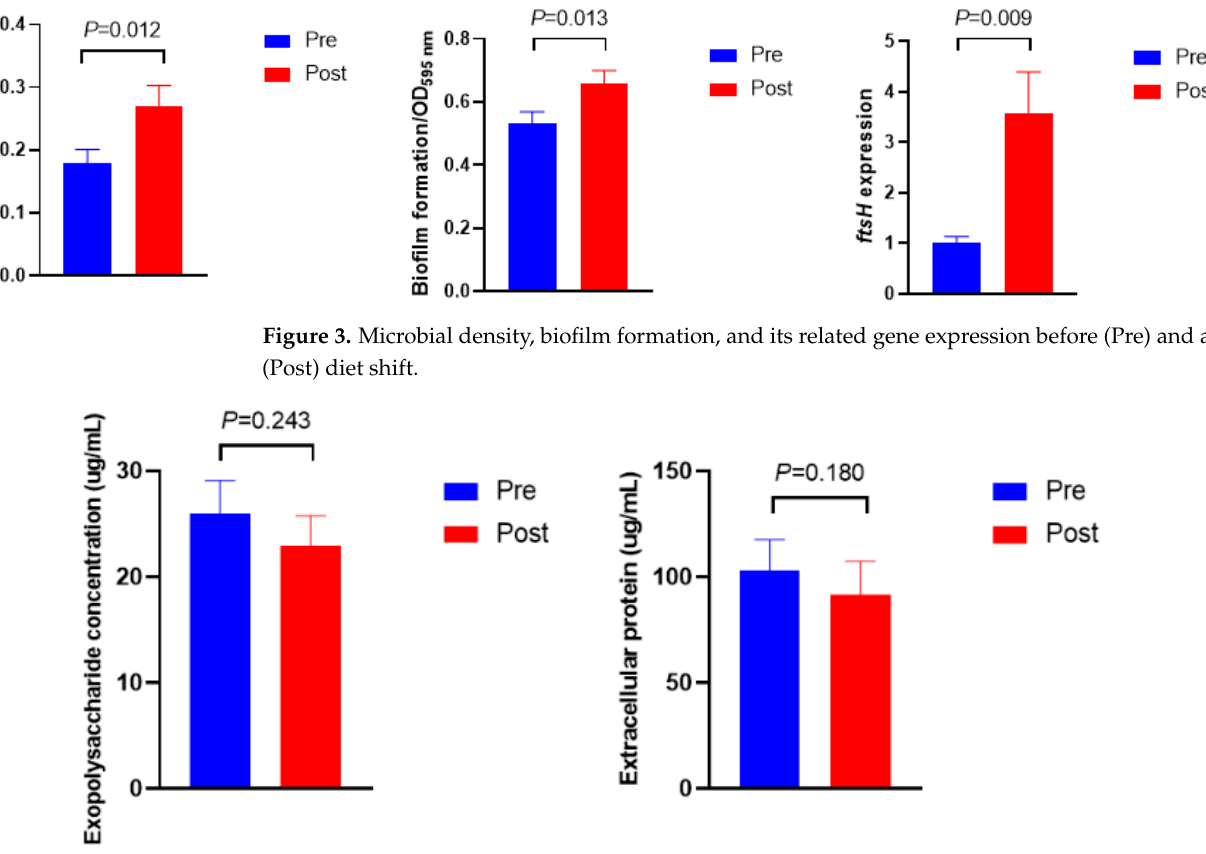
Figure 4. Exopolysaccharide and protein concentrations of extracellular polymeric substances before (Pre) and after (Post) diet shift.